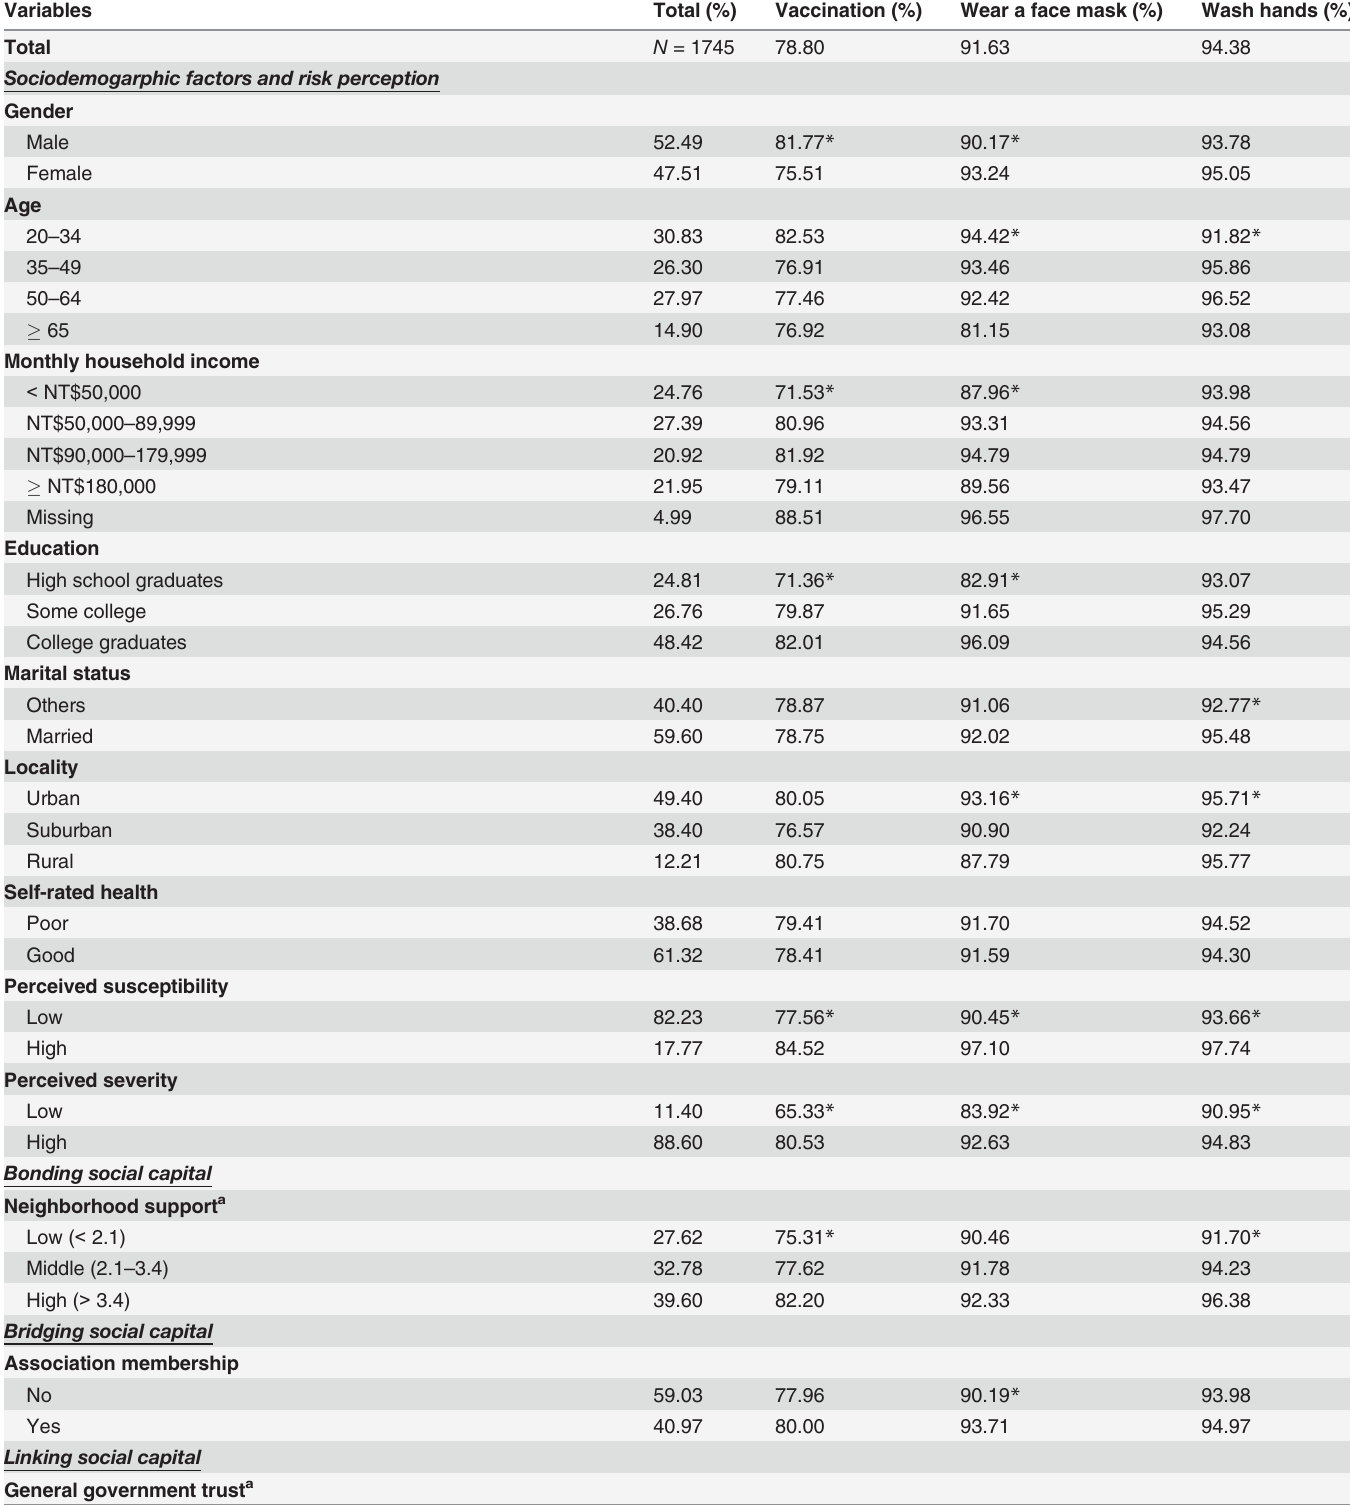
Table 1. Descriptive statistics for the study variables and chi-squared tests for the intention to engage in health-protective behaviors.